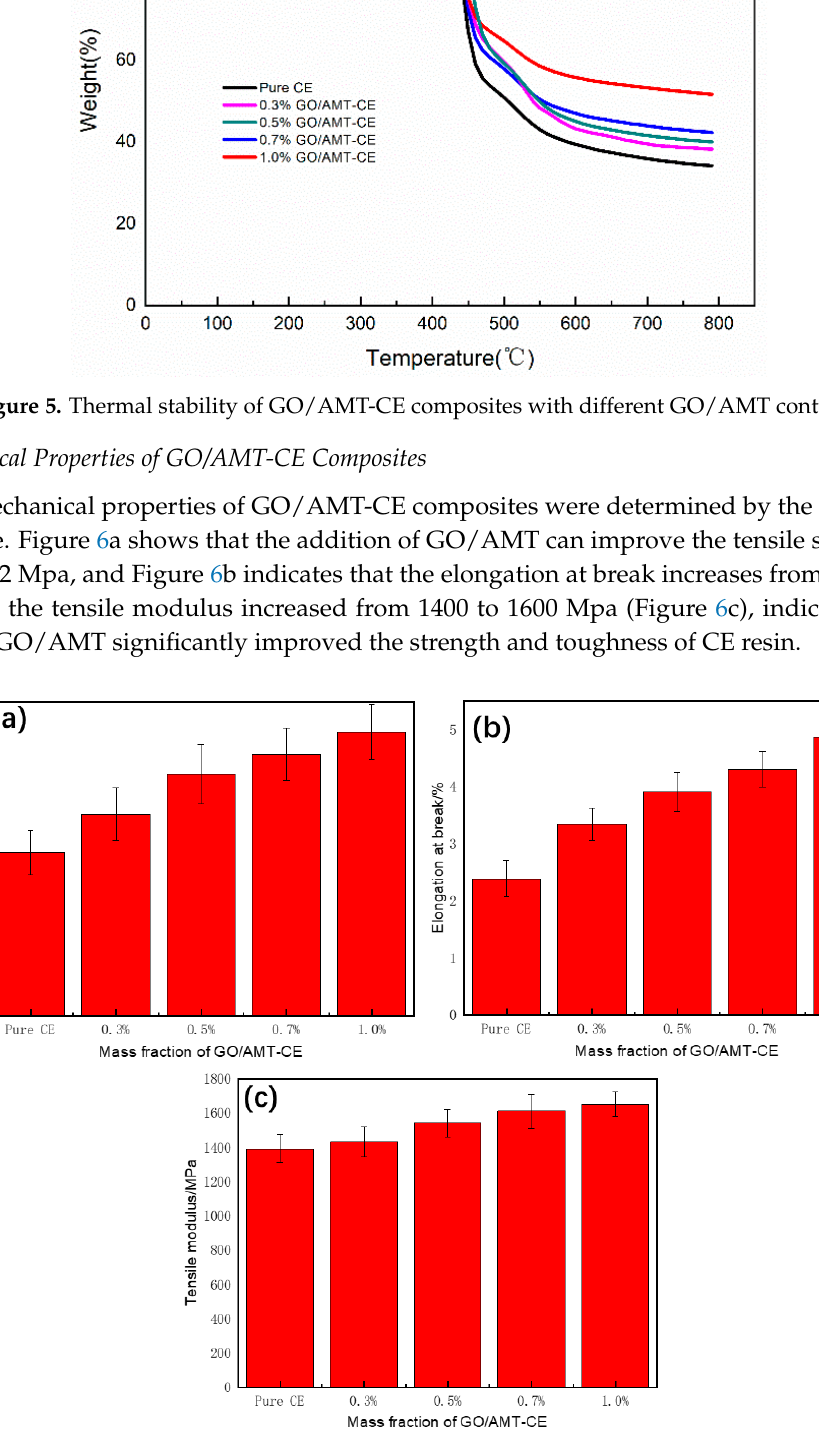
Figure 6. Mechanical properties of GO/AMT-CE with different GO/AMT contents: ( a ) tensile storage ( b ) elongation at break, and ( c ) tensile modulus.